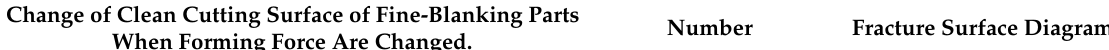
Table 5. Finite element simulation results and fracture surface diagram.